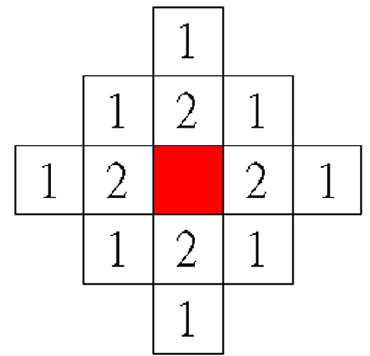
Figure 8. Diagram of the weight values for two-dimensional neighborhood relationship.